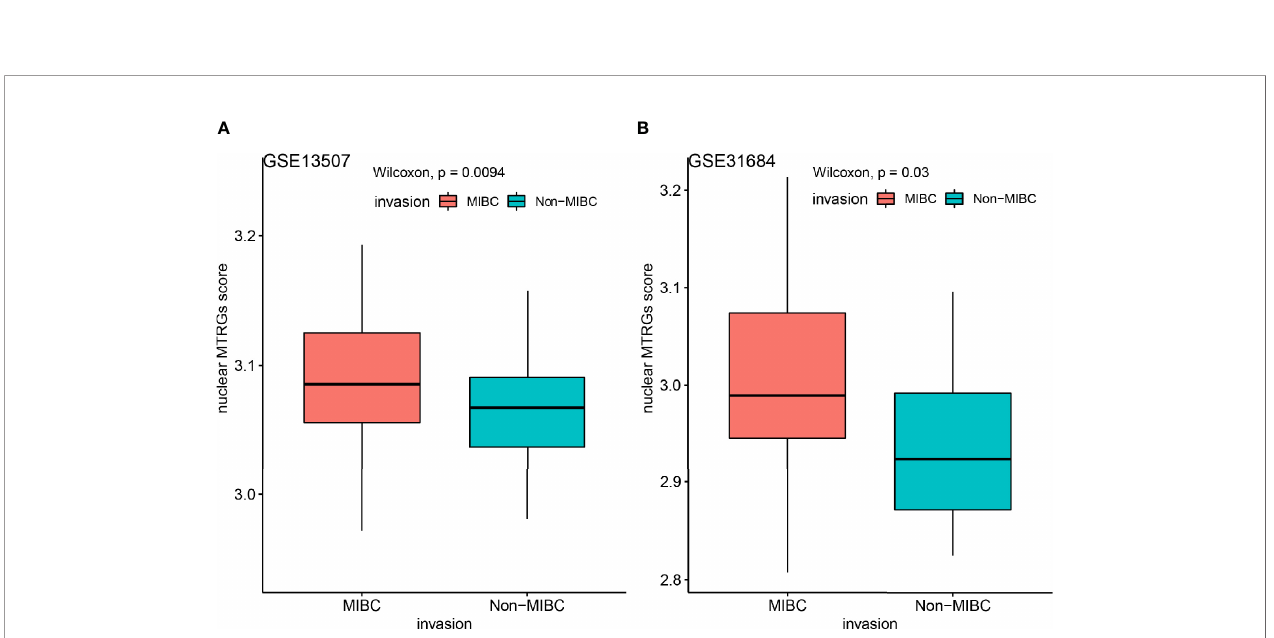
FIGURE 4 | Comparing the nuclear MTRGs score of the NMIBC and MIBC groups in two independent datasets of GSE13507 (A) , GSE31684 (B)